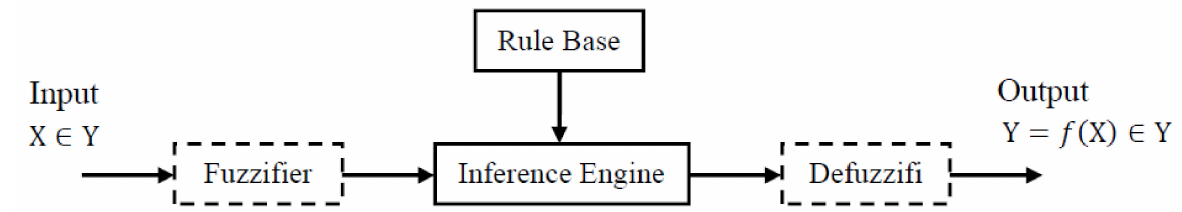
Figure 3. Construction of a